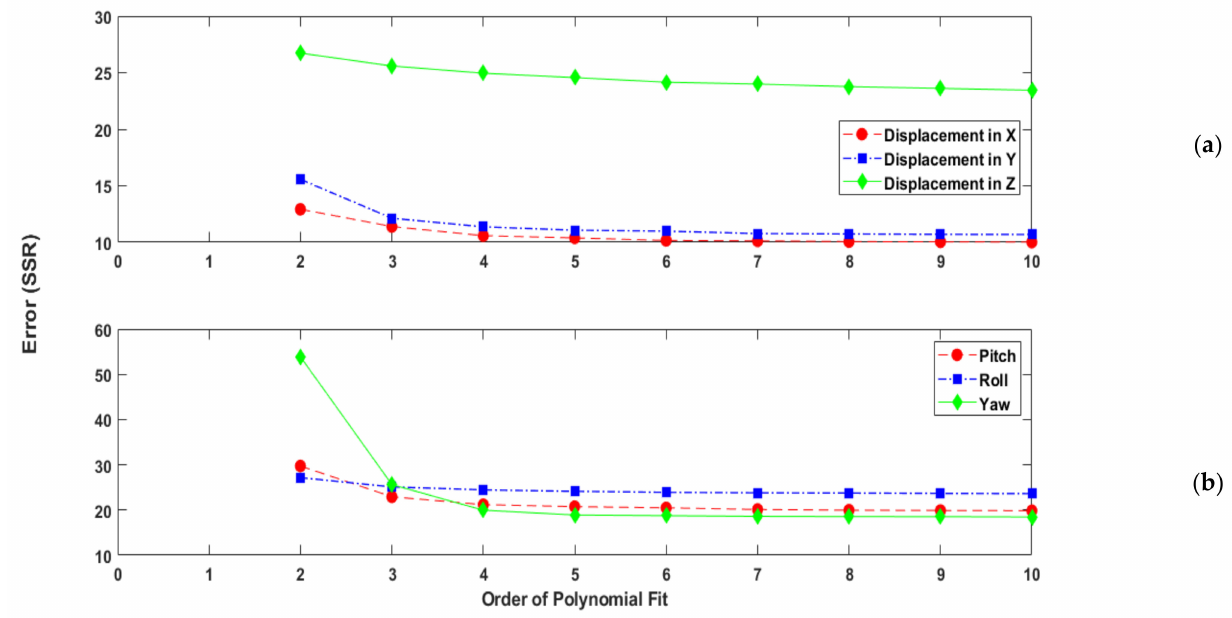
Figure 8. Square Sum of Residual (SSR) errors with increasing polynomial order. ( a ) Displacement in x, y and z. ( b ) Rotation in pitch, roll and yaw.